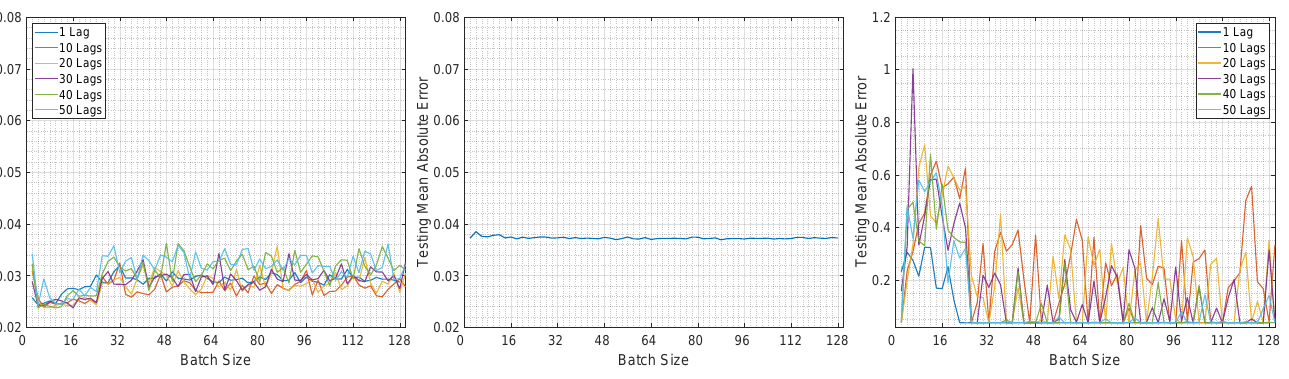
Figure 20. Illustration of the testing mean absolute error value for Experiment 2, LSTMTF ( left ), VLSTM ( middle ), and LSTMTFC ( right ), using a many-to-many prediction mode.